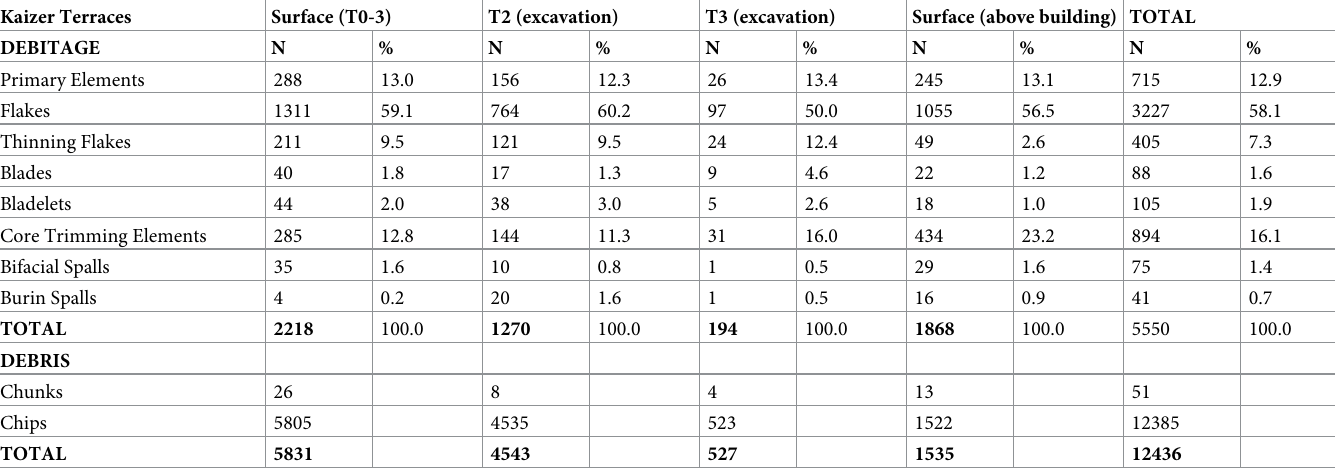
Table 4. Debitage and debris categories–Kaizer Hill